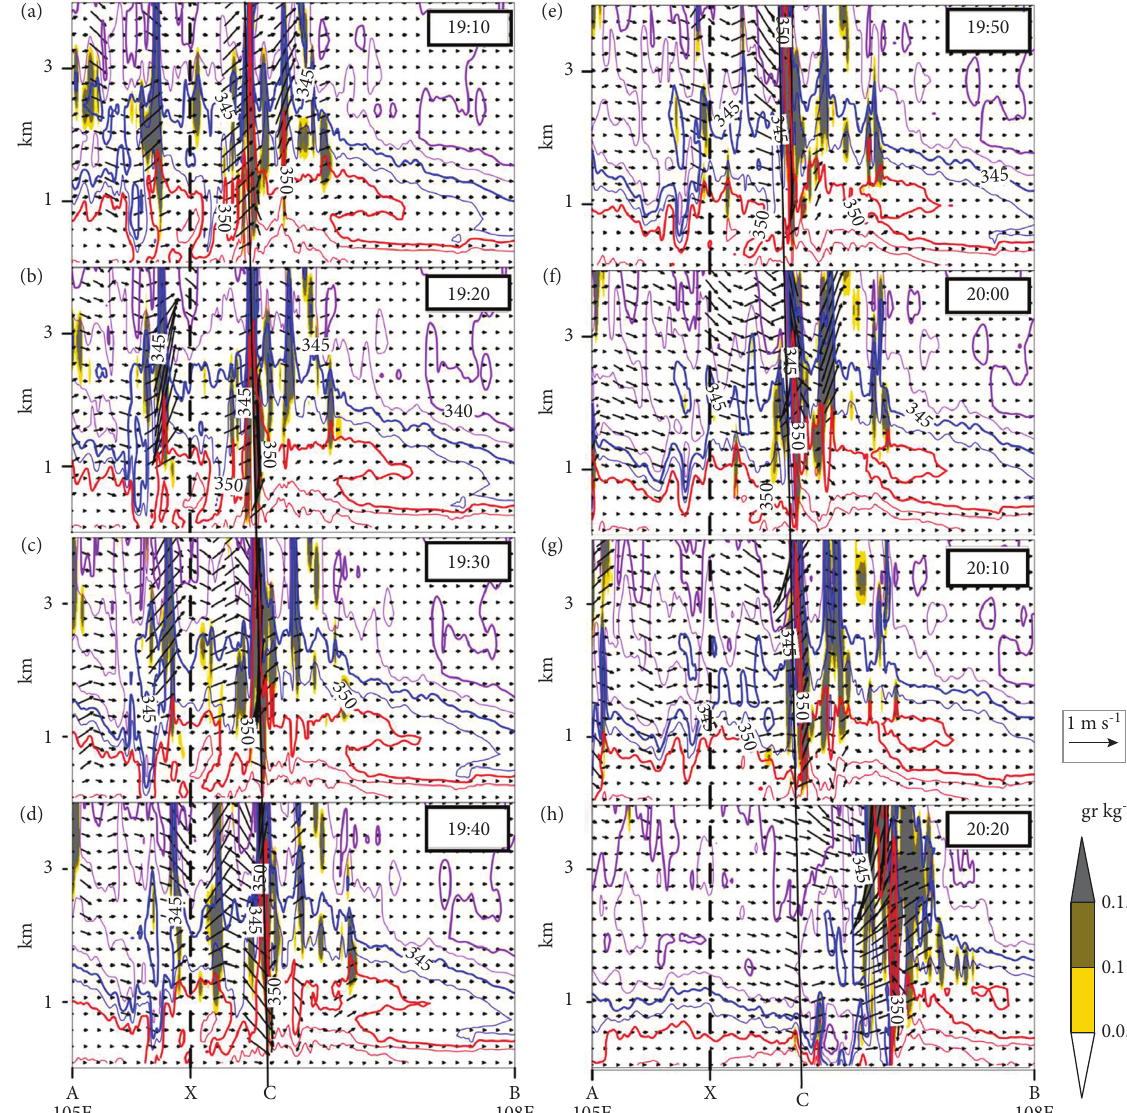
Figure 9: Same as Figure 8, but from 19:10 to 21:40 LST. The black vertical solid line (C) represents location (154km from (X) of a stationary convection cell from 19:00 LST (see Figure 8) to 20:10